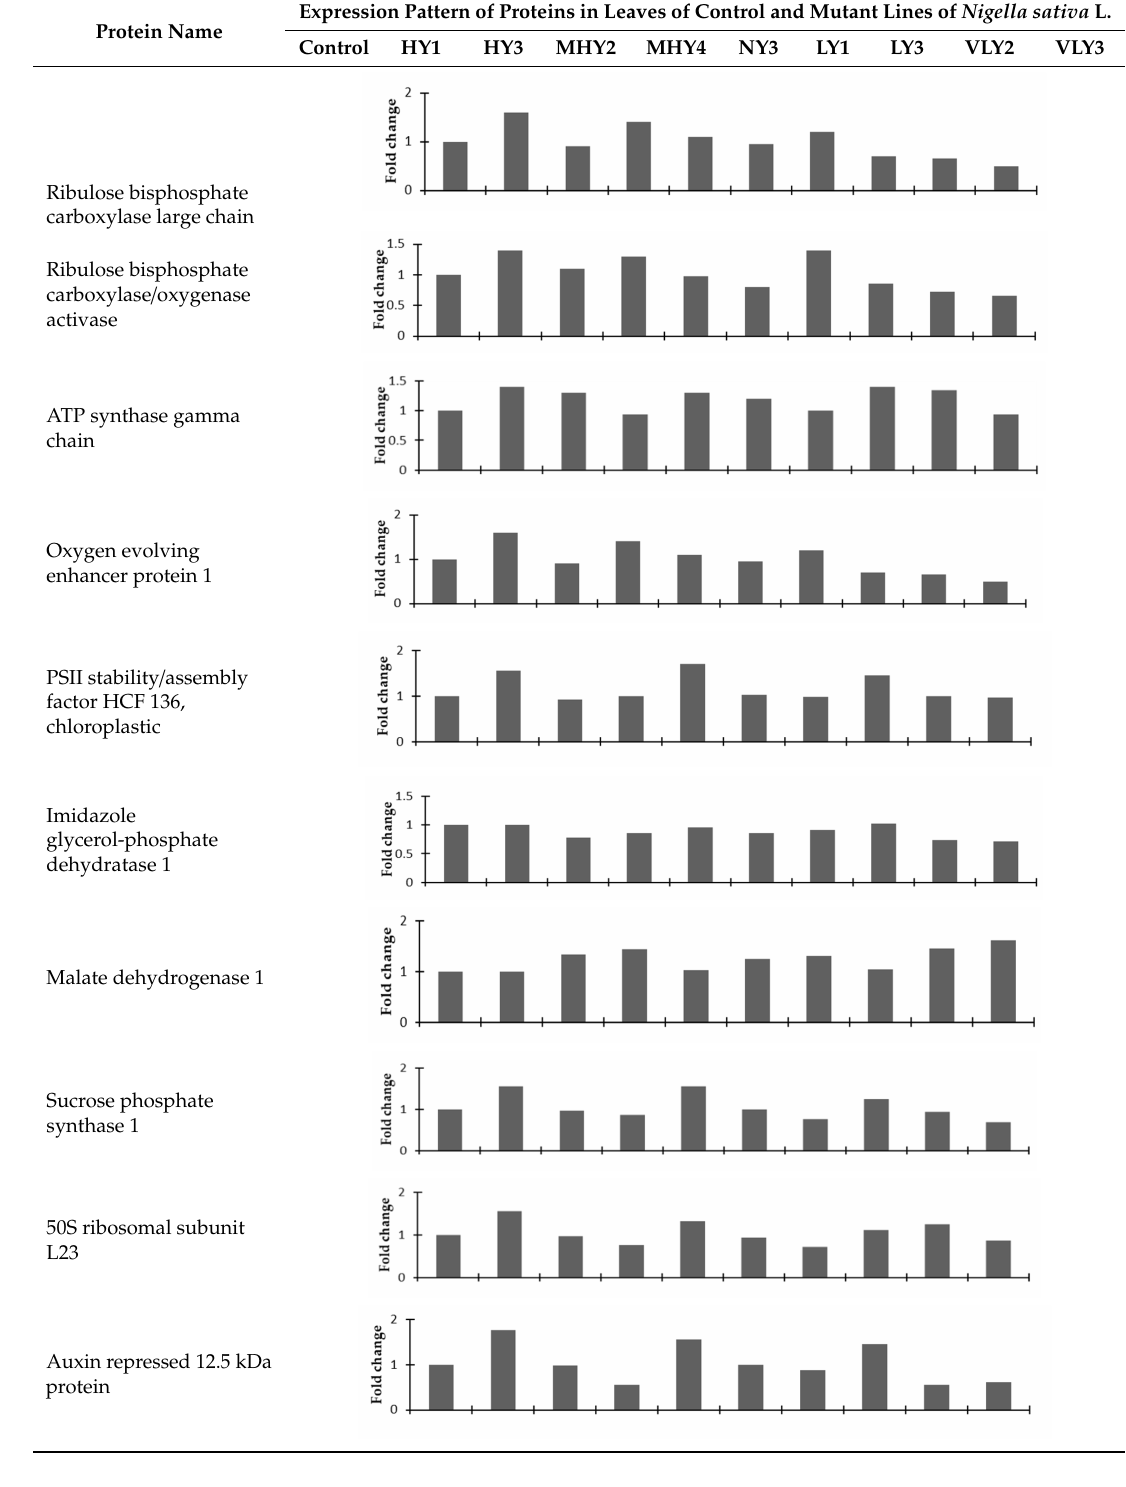
Table 5. Fold-change abundance of di ff erentially expressed leaf proteins of the control and the mutants of Nigella sativa